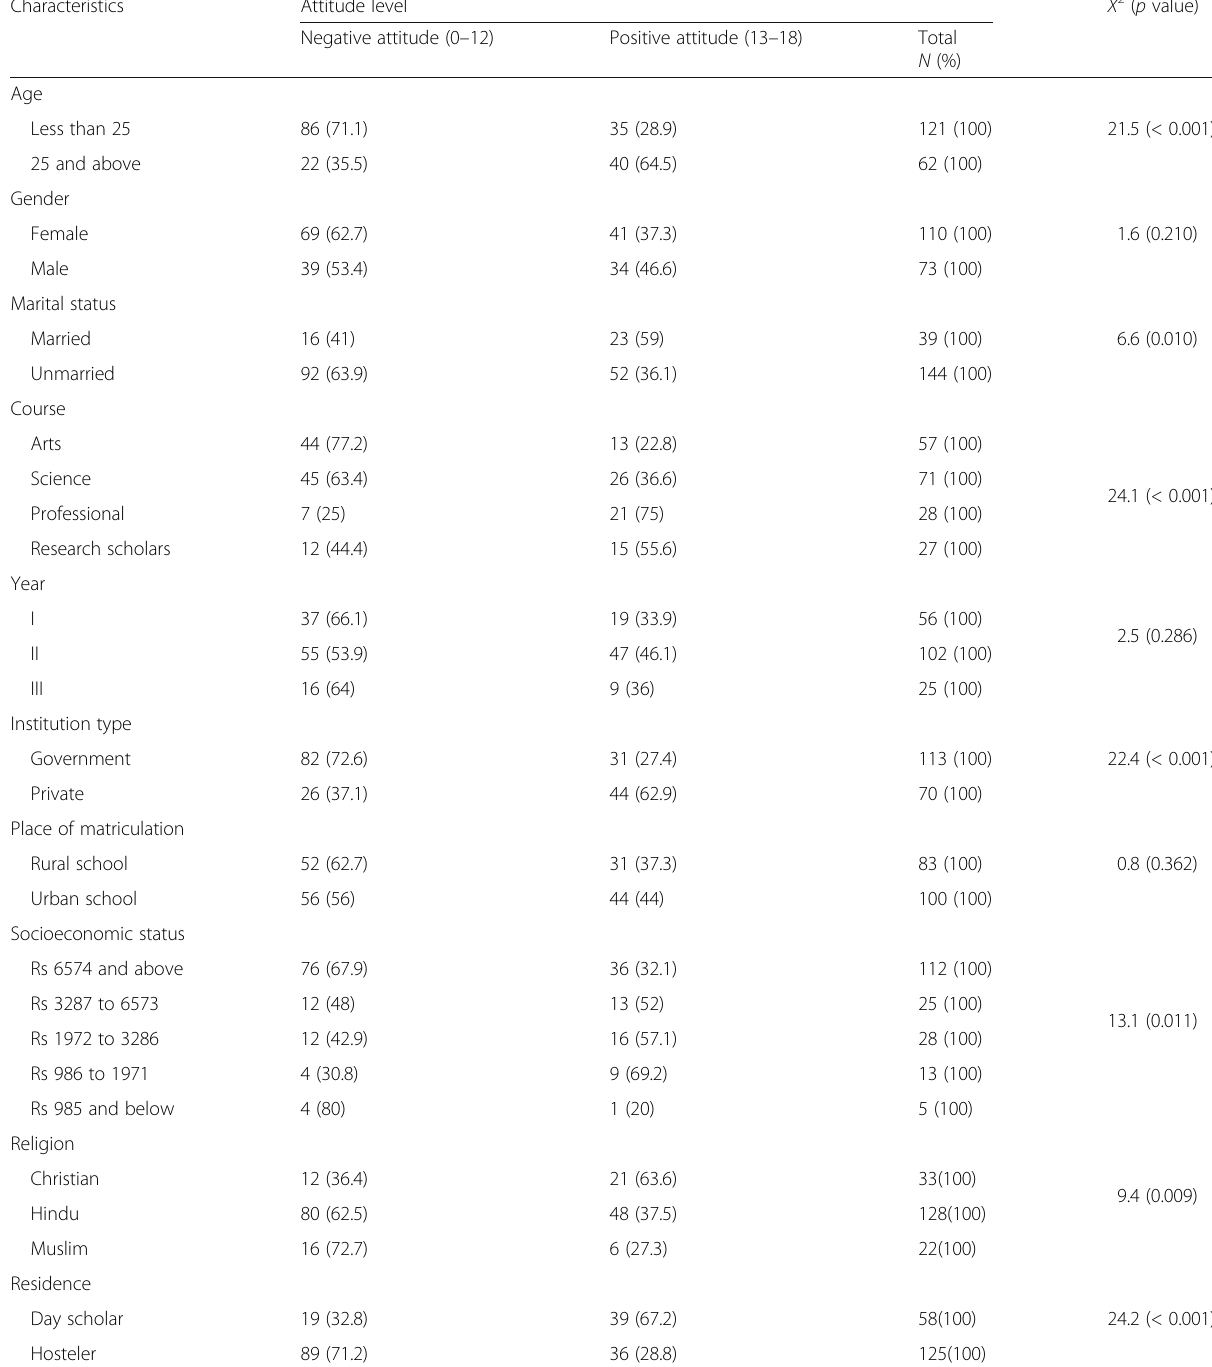
Table 5 Association between sociodemographic variable and attitude of college students regarding emergency contraception ( n =